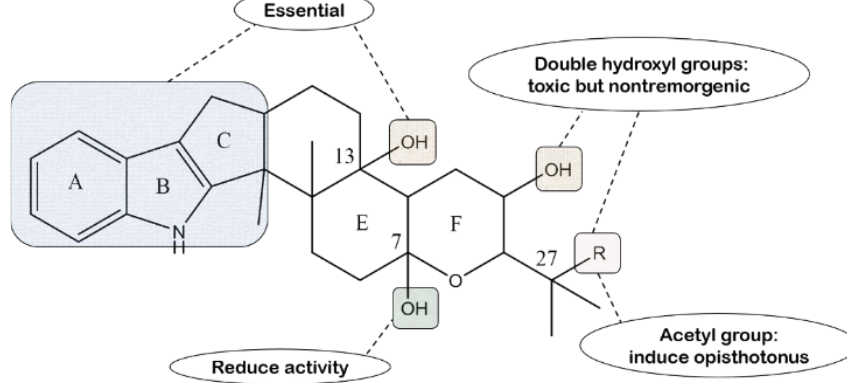
Figure 19. Structure – tremorgenic activity relationship of paxilline indole diterpenes.